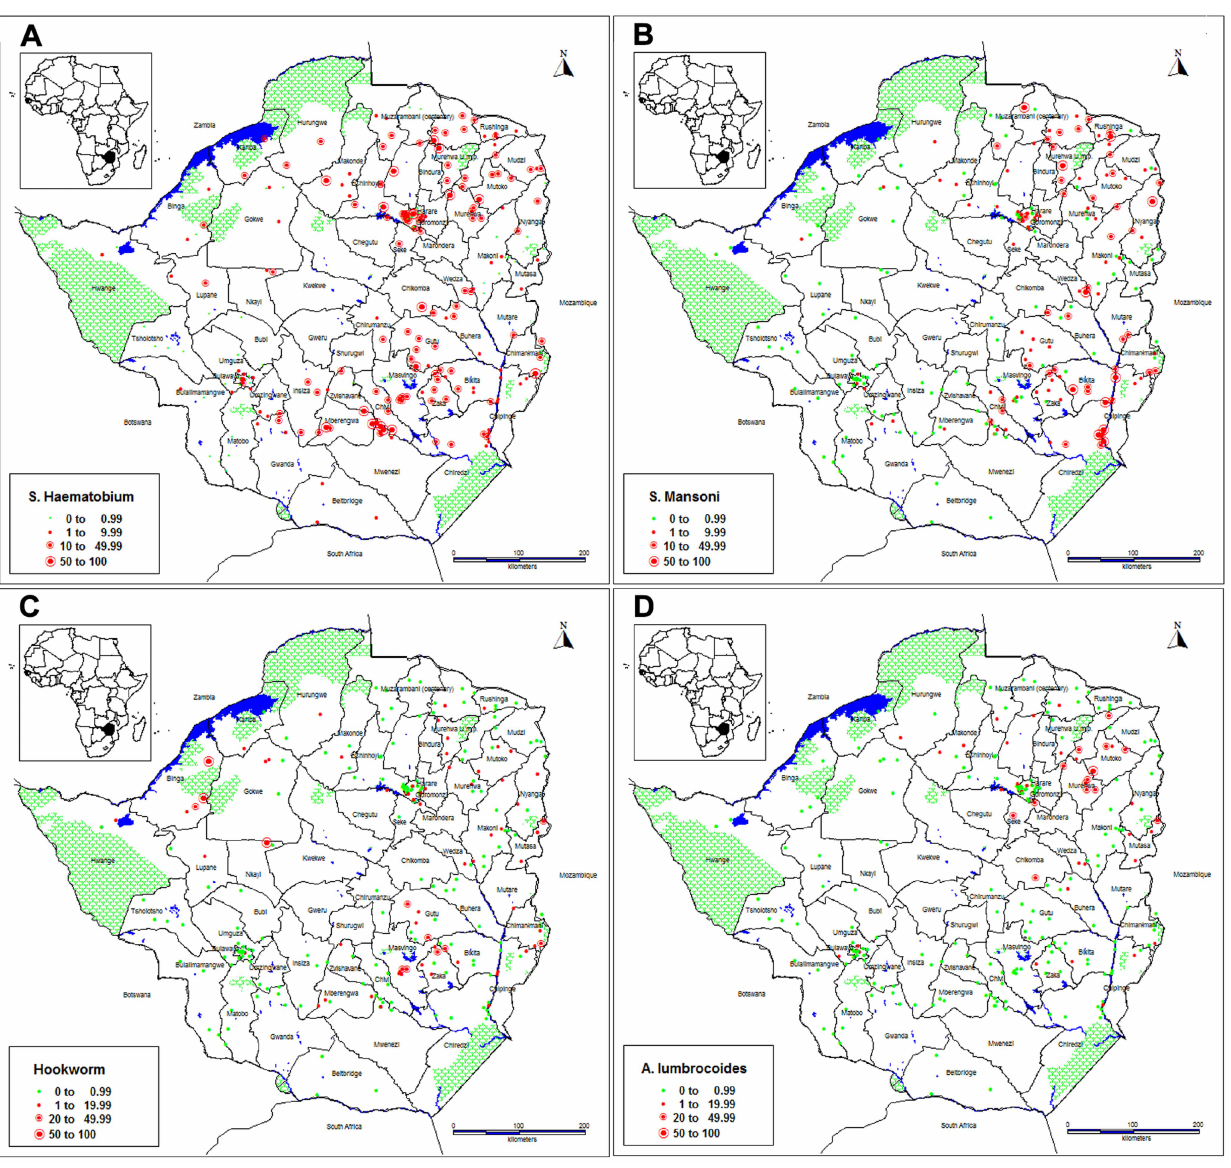
Figure 2. ( a ) Point prevalence of S.haematobium in 280 primary schools in Zimbabwe during 2011 school calendar. ( b ) Point prevalence of S. mansoni in 256 primary schools in Zimbabwe during 2011 school calendar. ( c ) Point prevalence of hookworms in 256 primary schools in Zimbabwe during 2011 school calendar. ( d ) Point prevalence of A. lumbricoides in 256 primary schools in Zimbabwe during 2011 school calendar.